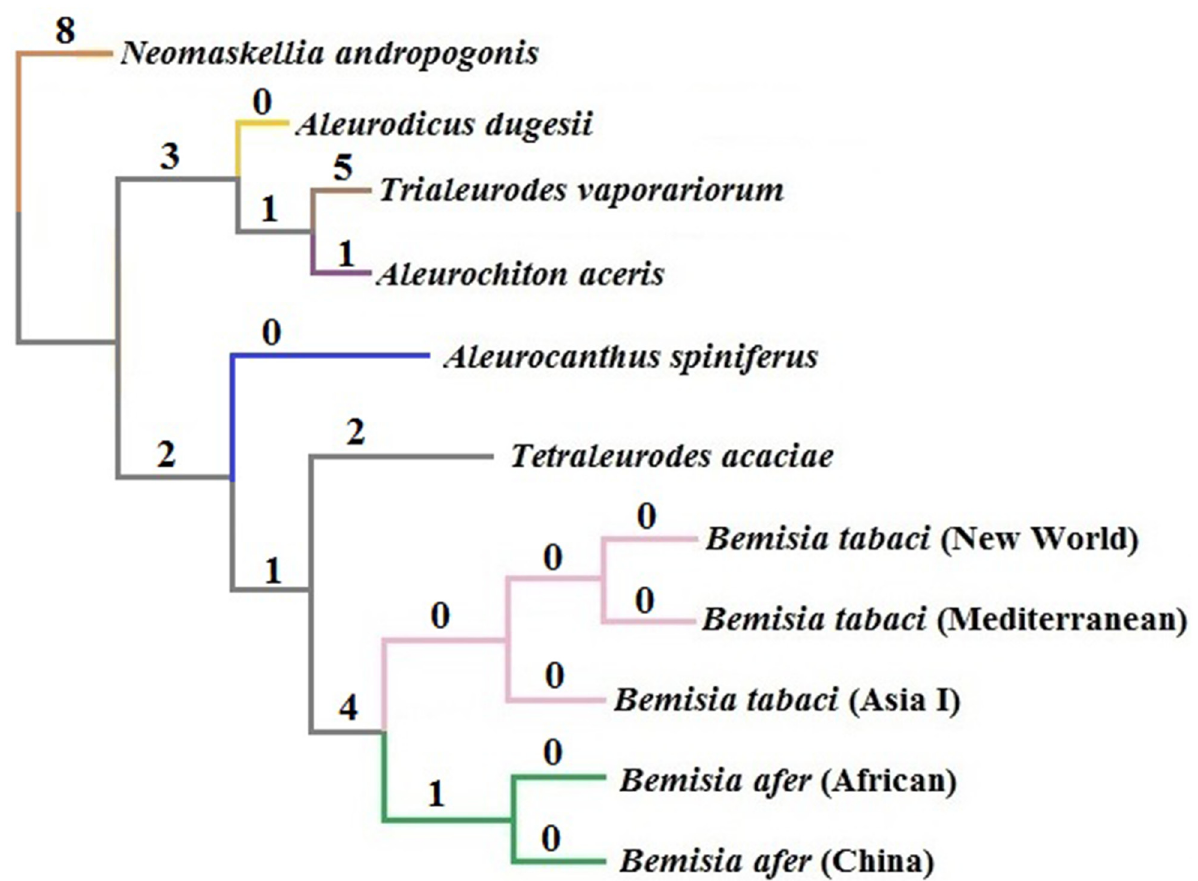
Fig 9. Phylogeny of 11 whitefly mitogenomes reconstructed by MGR. The number of rearrangements is shown numerically on the branches.